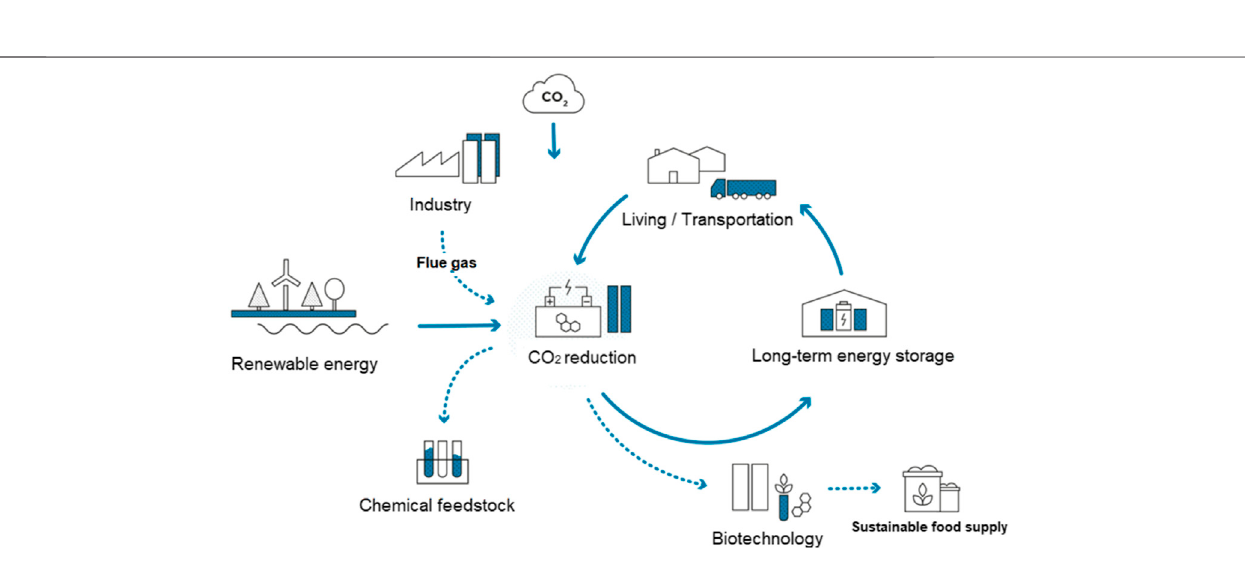
FIGURE 3 | CO 2 Utilization — a sustainable and climate-friendly